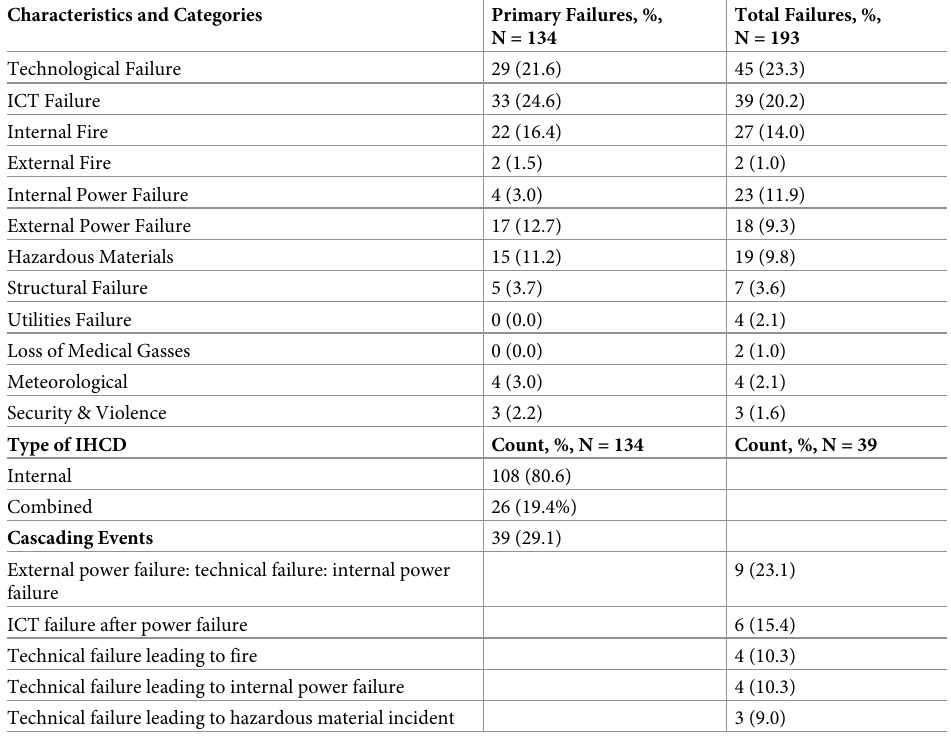
Table 2. Internal hospital crises and disasters (IHCDs) characteristics in failure type, localization and cascading events of IHCDs occurring in Dutch hospitals from 2000 to 2019. Characteristics and Categories